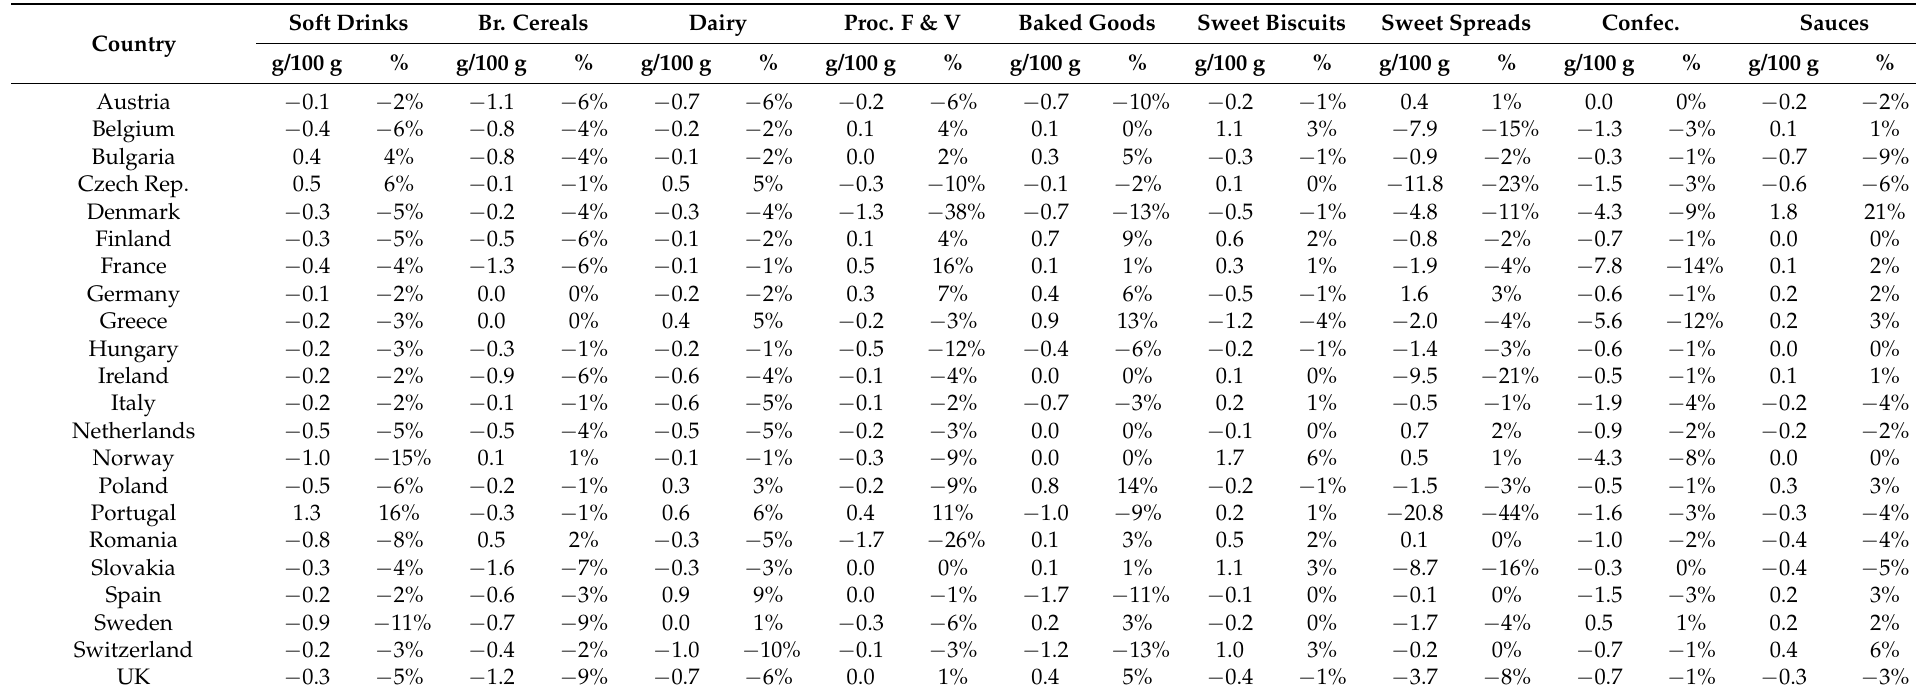
Table A3. Changes in the market-share weighted mean of total sugars (in g/100 g and %) between 2015 and